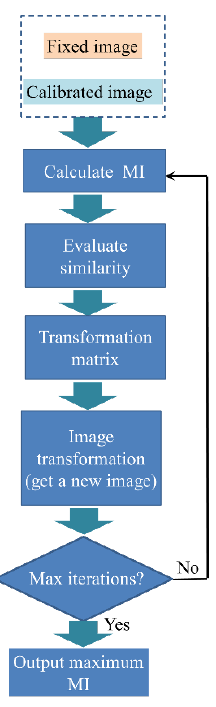
Figure 2. Image registration process.